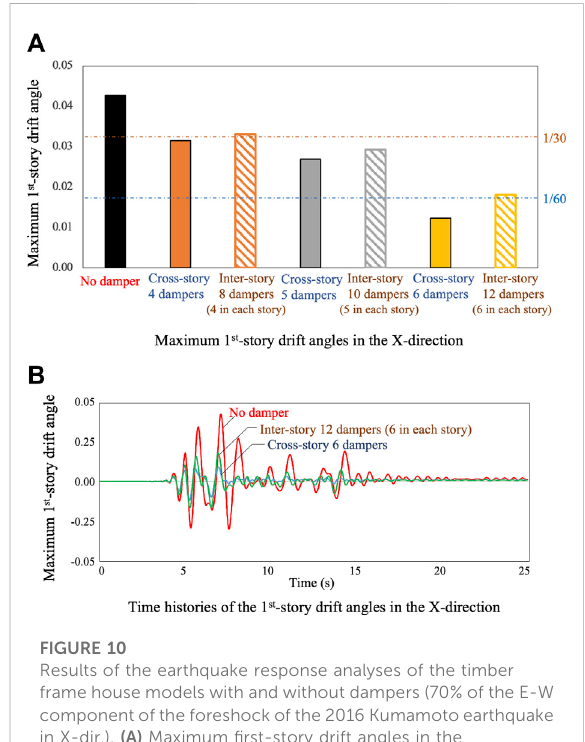
FIGURE 10 Results of the earthquake response analyses of the timber frame house models with and without dampers (70% of the E-W component of the foreshock of the 2016 Kumamoto earthquake in X-dir.). (A) Maximum fi rst-story drift angles in the X -direction (B) Time histories of the fi rst-story drift angles in the X -direction.